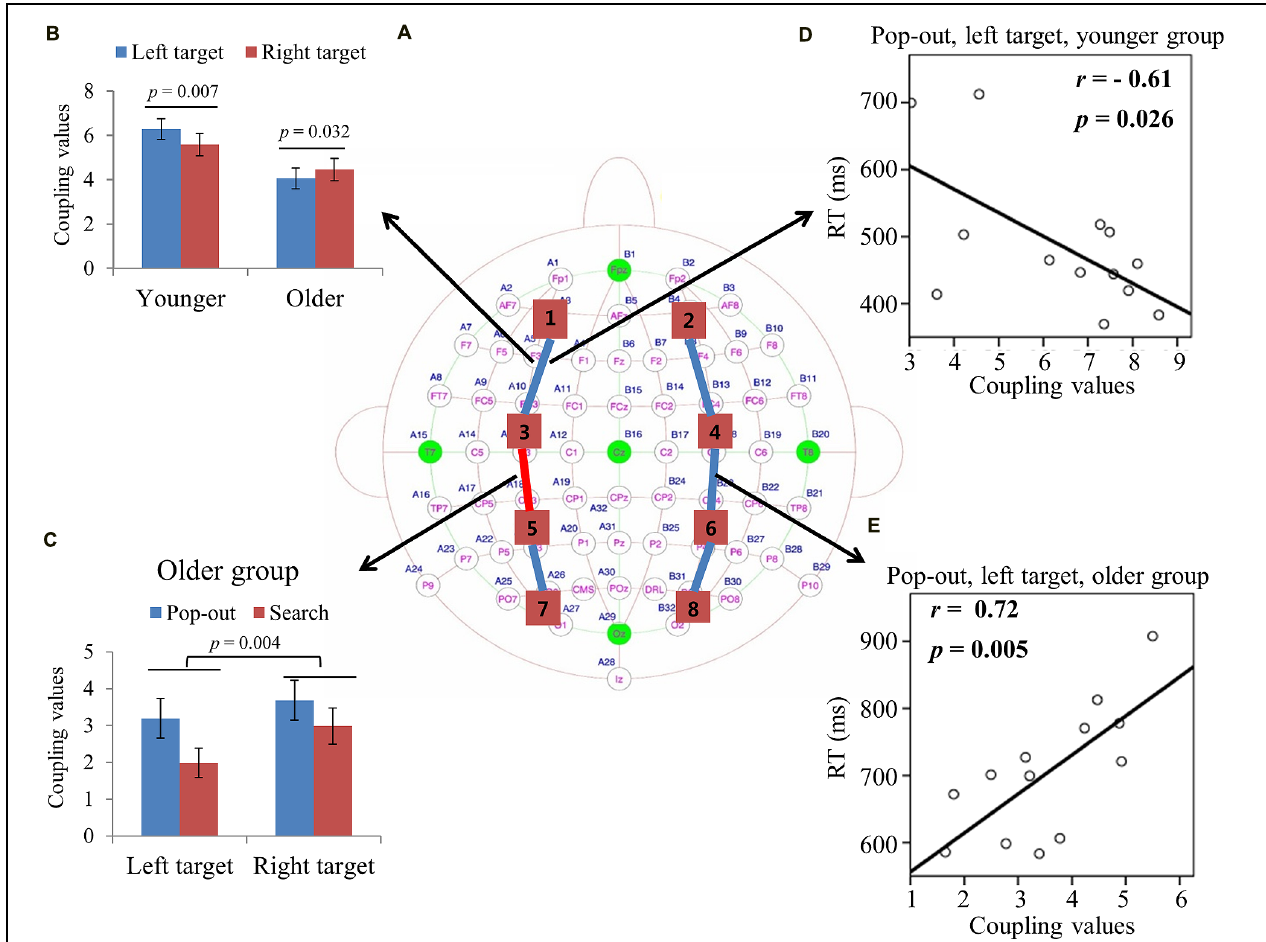
FIGURE 3 | (A) Inter-regions coupling in theta frequency band. Blue lines indicate main effect of age (younger > older) and red line indicates main effect of condition (pop-out > search). (B) Coupling values between left prefrontal and central-frontal regions as a function of target visual field in younger and older subjects, with greater coupling values in left target than in right target for younger subjects and greater coupling values in right target than in left target for old subjects. (C) Coupling values between left central-frontal and central-parietal regions as a function of target visual field in both conditions for older group, with greater values in pop-out condition and in right target, and no such effects for younger group. (D) Linear negative regression between mean RT and coupling value between left prefrontal and central-frontal regions for the pop-out condition with the left field target in the younger group. (E) Linear positive regression between mean RT and coupling value between right central-frontal and central-parietal regions for the pop-out condition with the left field target in the older